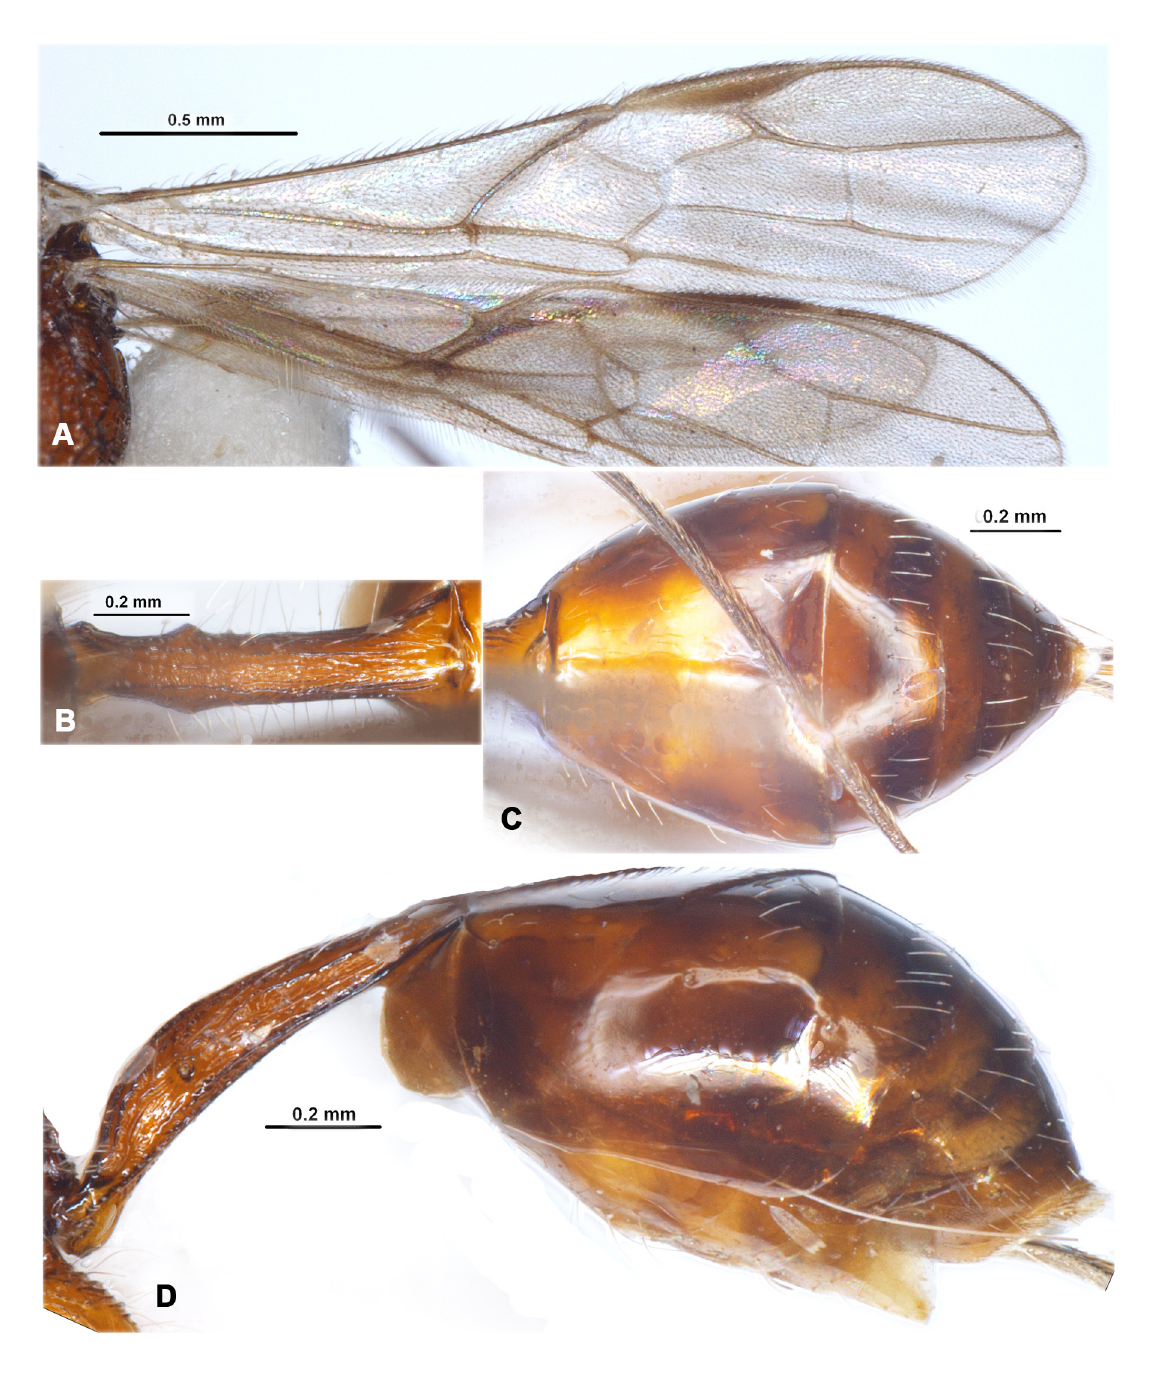
Fig. 23. Spathius nixoni Belokobylskij & Maetô, 2009, ♀ (RMNH). A . Wings. B . Petiole of metasoma, dorsal view. C . Metasoma without petiole, dorsal view. D . Metasoma, lateral